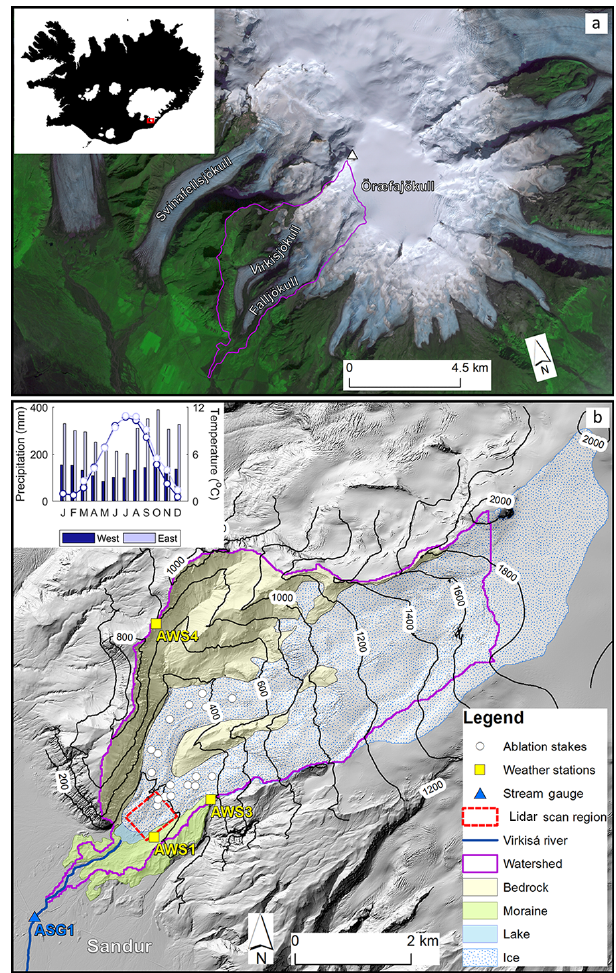
Figure 1. Location of Virkisá River basin on Öræfajökull (a) and detailed topographical map of the basin including major land sur- face types and observation data with inset showing mean monthly climate (b)